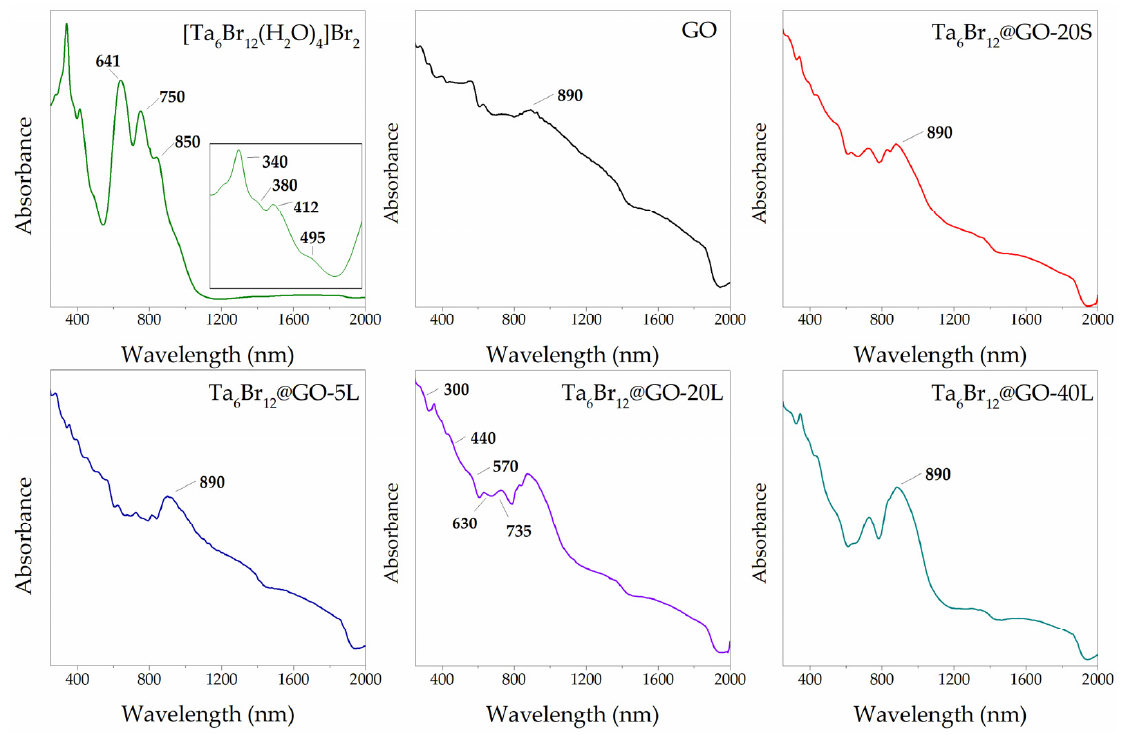
Figure 5. UV-vis DRS spectra of {Ta 6 Br i12 }@GO, [{Ta 6 Br i12 }Br a2 (H 2 O) a4 ]·4H 2 O and GO materials.